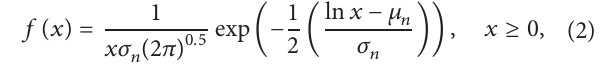
were longer than other stations. Thirty-one-year (1965–1995) monthly mean river discharge data at Chamriz hydrometric station and Twenty-one-year (1975–1995) monthly